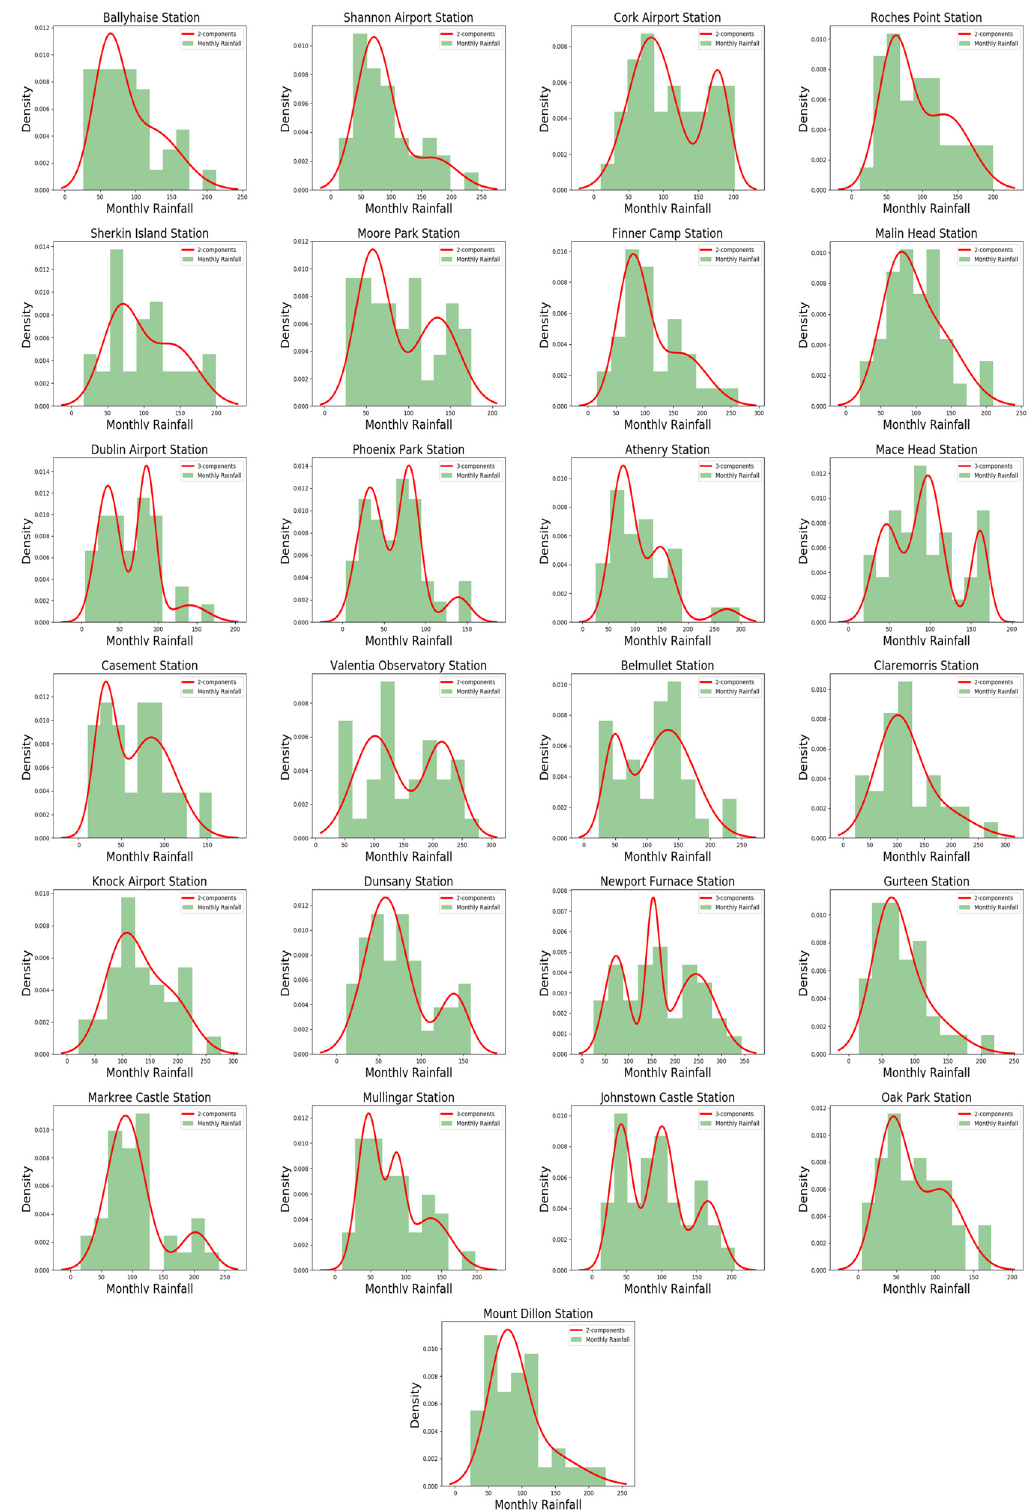
Figure 3: The best - fi tting model for each